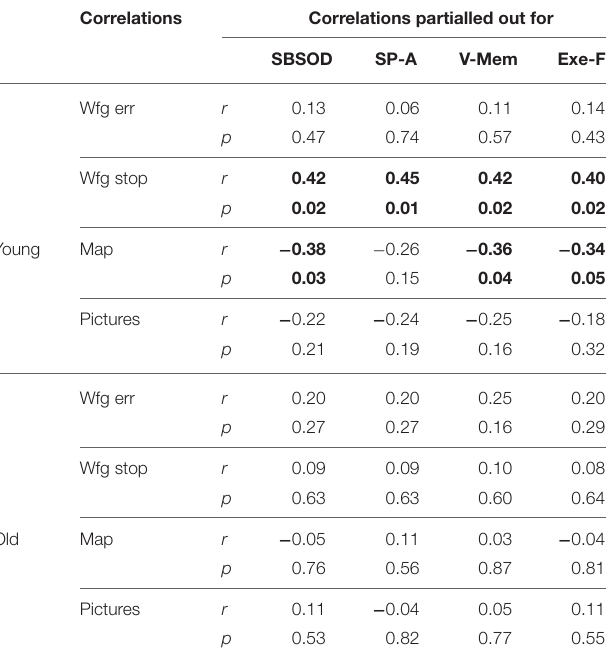
TABLE 5 | Correlations between direct (Wayfinding and Spatial memory scores) and self-reported (SBSOD score) navigation measures for each age group, before and after the controlling for each neurocognitive composite score (SP-A, V-Mem or Exe-F). Correlations Correlations partialled out for